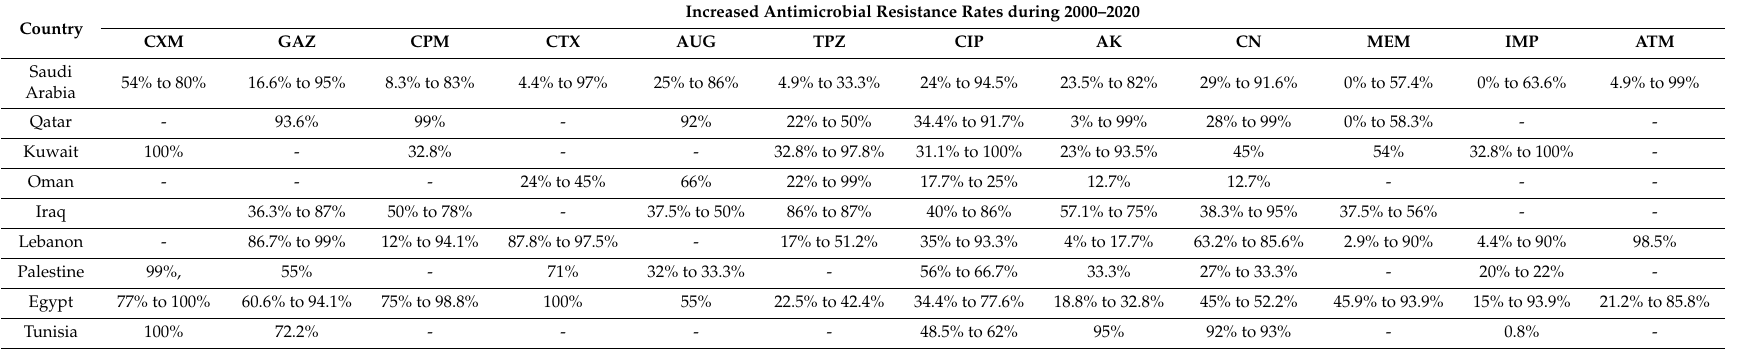
Table 1. Increased resistance rates to antimicrobial agents in E. coli and ESKAPE pathogens in the Arabian region for the years 2000–2020. Country